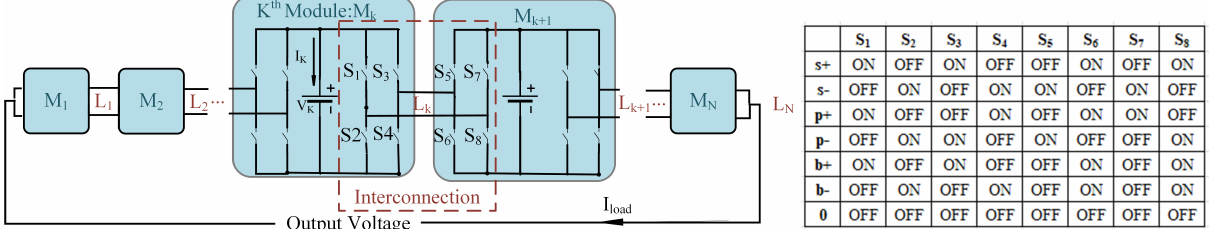
Figure 1. Proposed three-phase BESS arrangement.